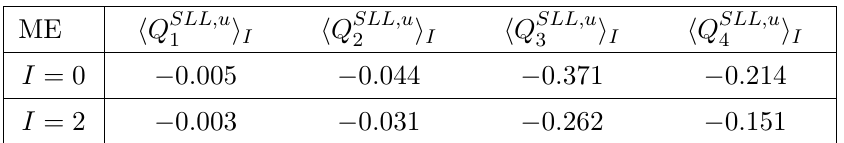
Table 1 . Value of hadronic matrix elements (MEs) in units of GeV 3 for K ! (cid:25)(cid:25) from the Q SLL;u operators at the (cid:22) = 1 : 3